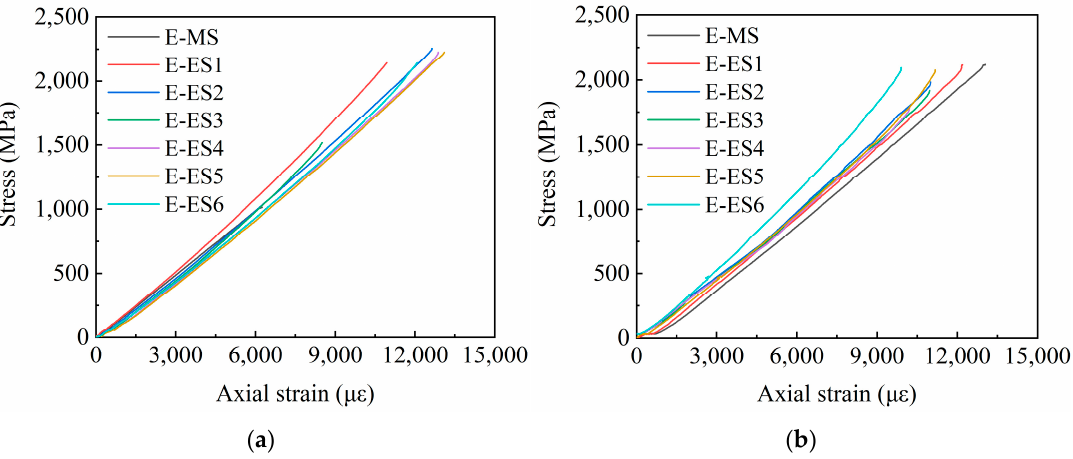
Figure 14. E-X group stress–strain curve. ( a ) E-1 stress–strain curve; ( b ) E-3 stress–strain curve.